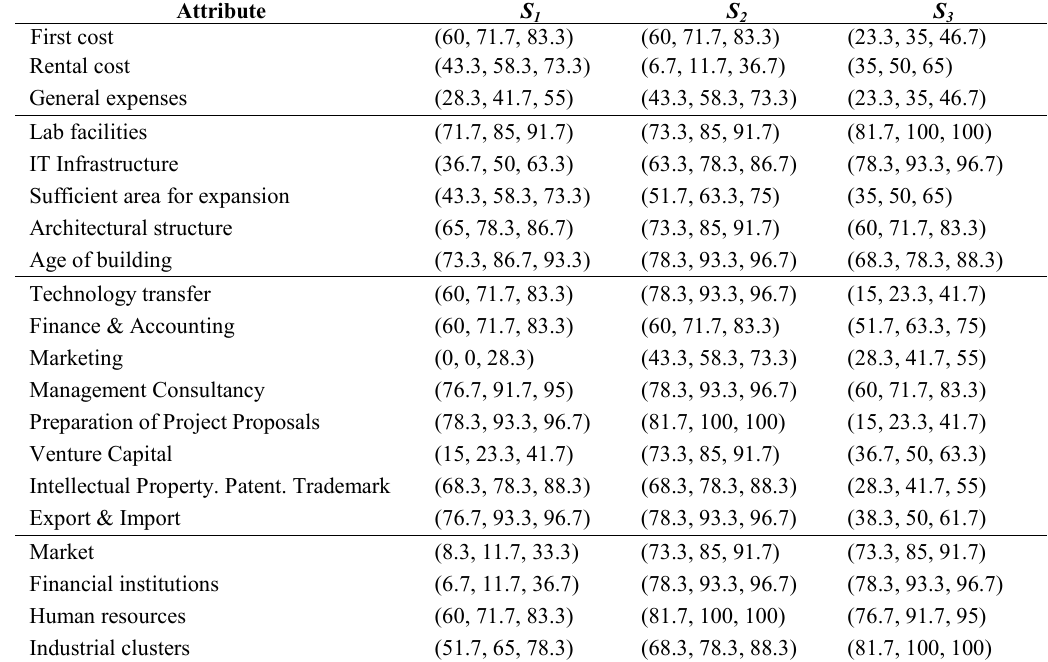
Table 4. Average fuzzy assessment values of each criterion for each science